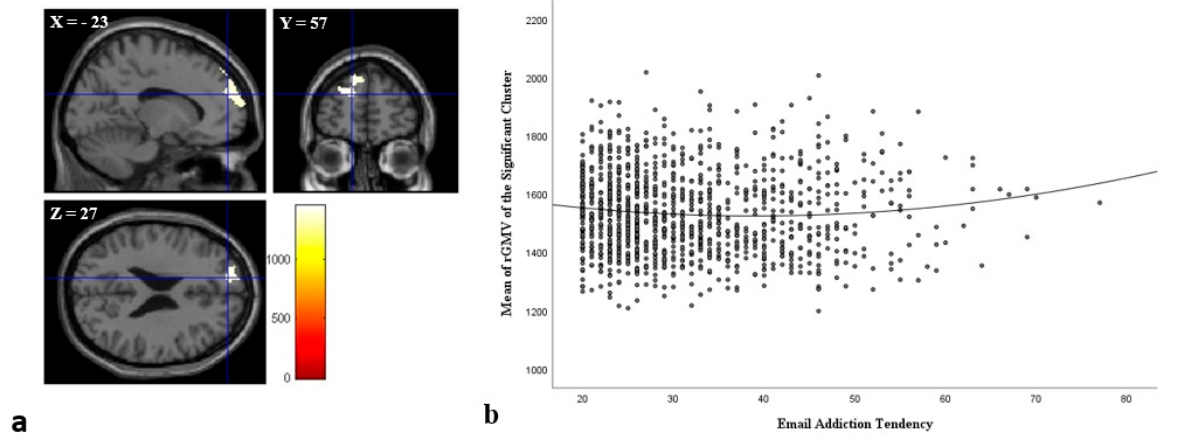
Figure 5. Gray matter brain regions correlate to email addiction tendency scores in young